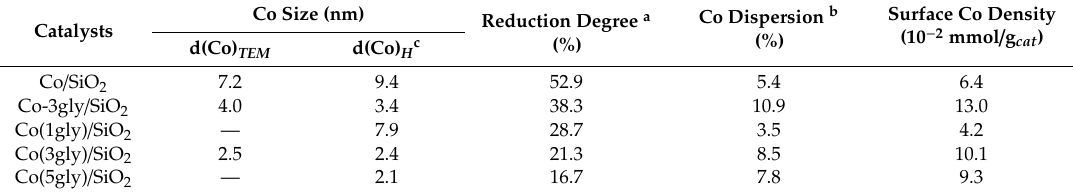
Figure 5. H 2 -TPR profiles for Co / SiO 2 (a), Co-3gly / SiO 2 (b), Co(1gly) / SiO 2 (c), Co(3gly) / SiO 2 (d), and Co(5gly) / SiO 2 (e). Table 2. Summarized cobalt properties over different catalysts.